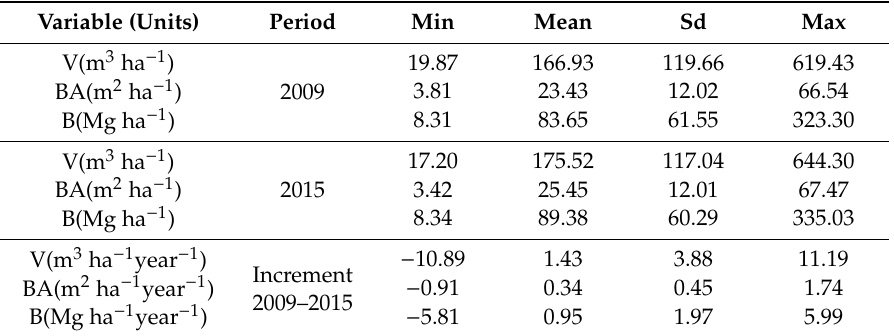
Table 1. Minimum (Min), mean (Mean), standard deviation (Sd), and maximum (Max) of the plot-level values for 2009, 2015 and yearly increments for the period 2009–2015. Values of volume V, basal area BA and biomass B are expressed on a per-hectare